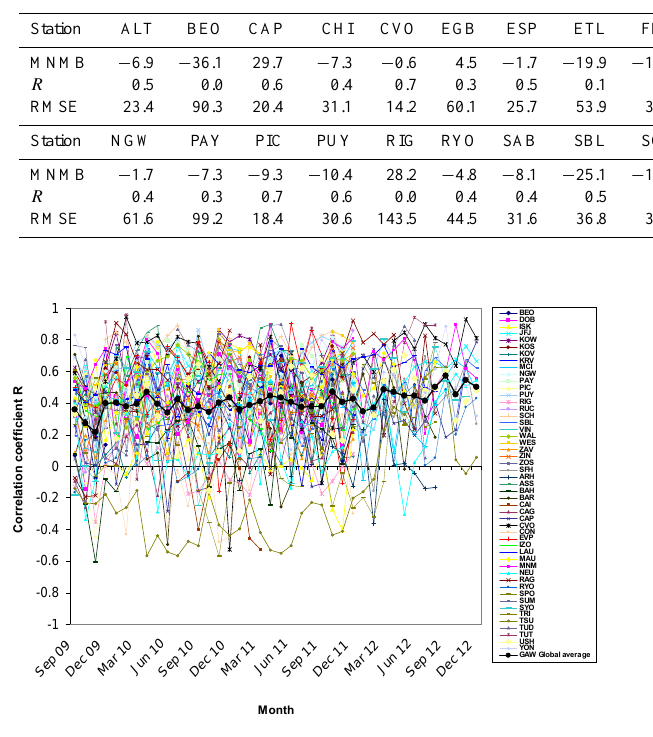
Figure 6. Correlation coefficient ( R ), derived from the evaluation of the MACC_osuite with GAW O 3 surface observations during the period September 2009 to December 2012 (black line: global av- erage of 50 GAW stations. Multi-coloured lines: individual station results; see legend to the right).